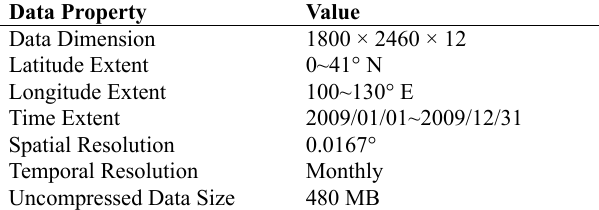
Table 1. Summary of the simulated air-sea SateCO 2 flux data